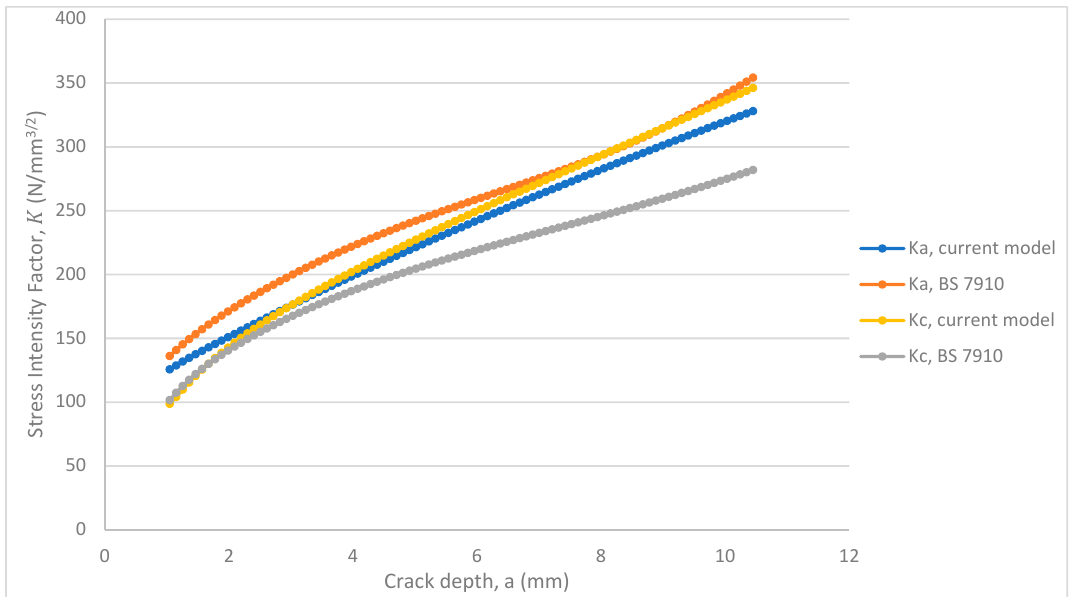
Figure 25. SIFs at the deepest point ( K a ) and surface point ( K c ) for an internal semi-elliptical crack in a pipe under cyclic tension (initial a / c = 0.25).